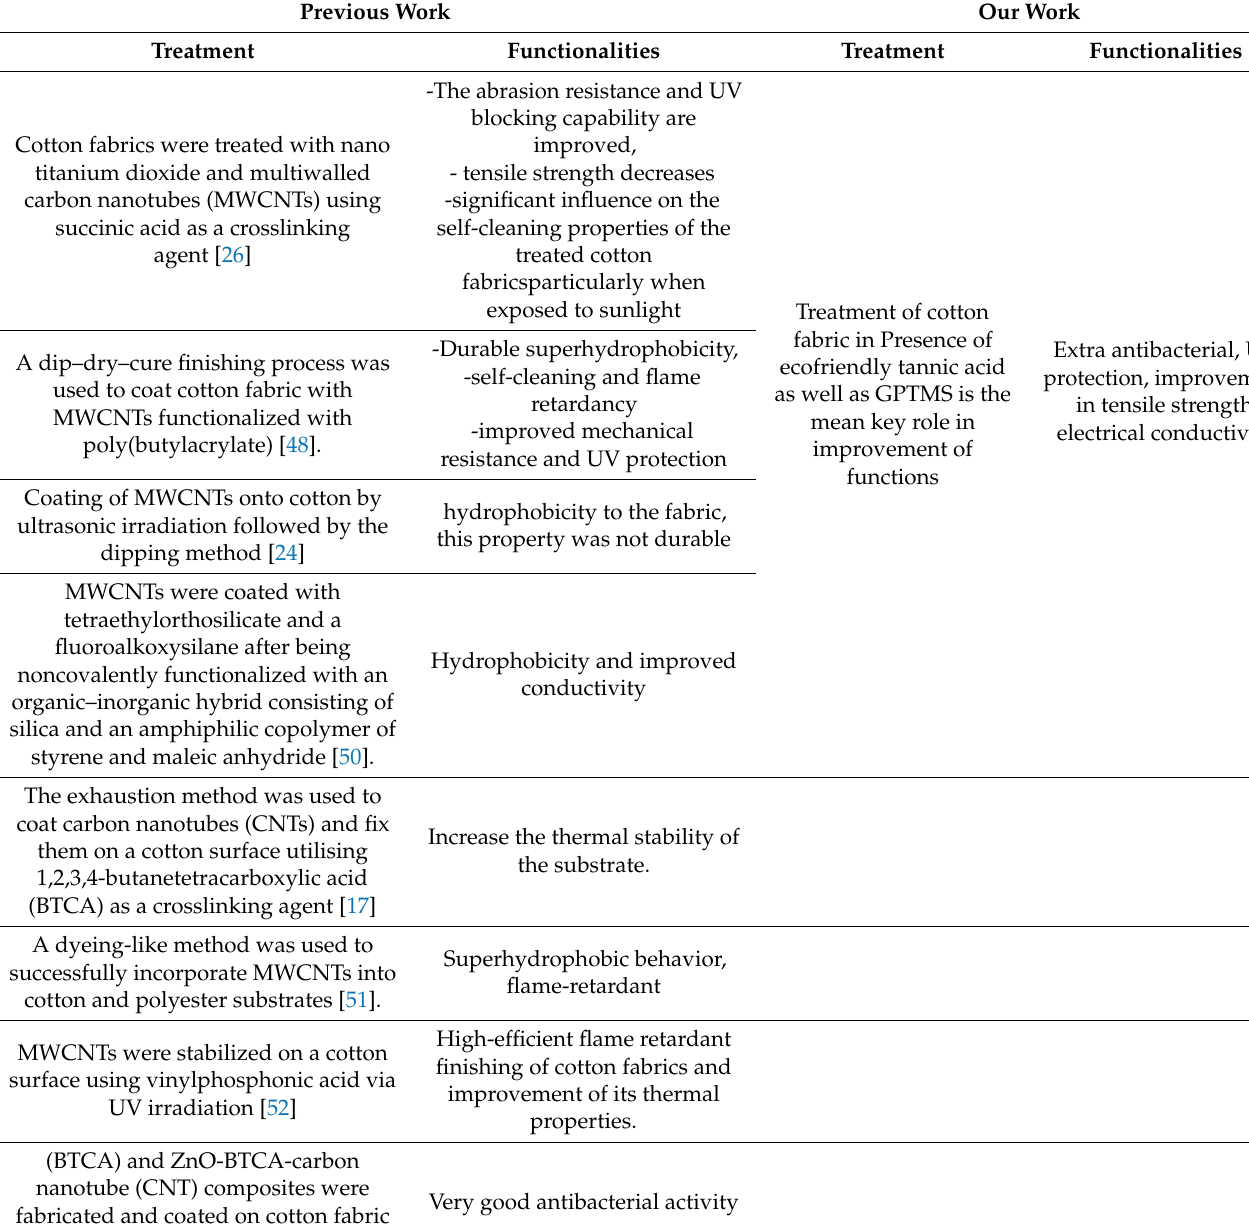
Table 5. Comparison between previous work and our